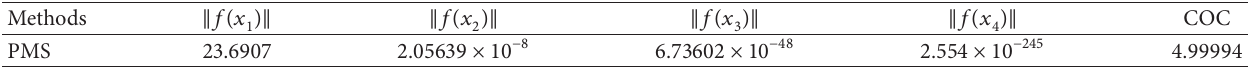
Table 3: Results of comparisons for Example